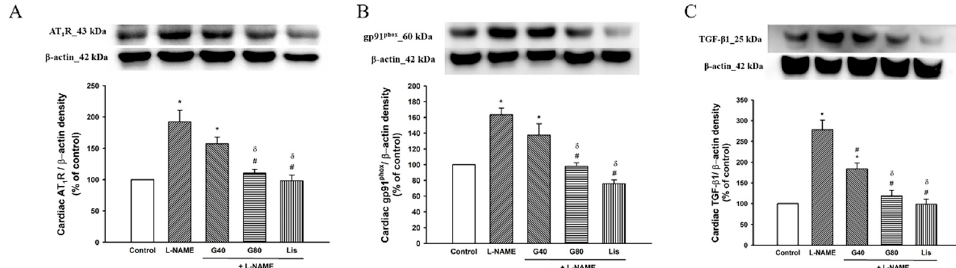
Figure 7. Effect of genistein or lisinopril on AT 1 R ( A ), gp91 phox ( B ), and TGF- β 1 ( C ) in cardiac tissue in rats treated with L-NAME. Data are expressed as mean ± SEM. * p < 0.05 vs. control, # p < 0.05 vs. L-NAME, and δ p < 0.05 vs. G40 ( n = 4/group). AT 1 R, angiotensin II receptor type I; gp91 phox , nicotinamide adenine dinucleotide phosphate oxidase subunit 2; TGF- β 1, transforming growth factor beta I; control, normotensive rats; L-NAME, N ω -nitro-L-arginine methyl ester hydrochloride; L-NAME + G40, L-NAME hypertensive rats treated with genistein 40 mg/kg; L-NAME + G80, L-NAME hypertensive rats treated with genistein 80 mg/kg; and L-NAME + Lis, L-NAME hypertensive rats treated with lisinopril 5 mg/kg.